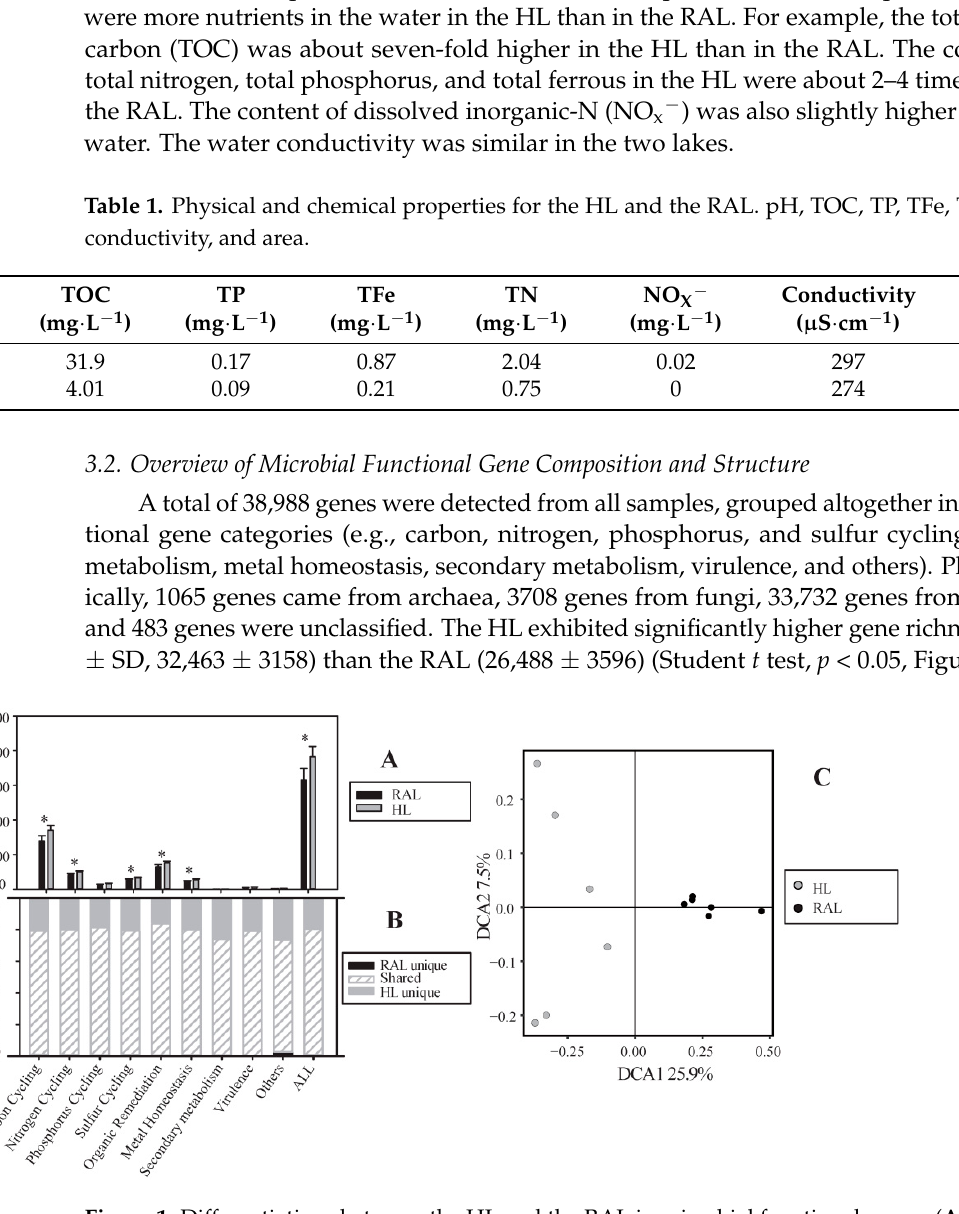
Figure 1. Differentiations between the HL and the RAL in microbial functional genes. ( A ) gene rich- ness, significant differences between the HL and the RAL were signified with the “*” above the middle of bars for different gene categories; ( B ) the distributions (shared or unique) of the detected genes in certain biogeochemical cycling processes; and ( C ) the plot showing detrended correspondence analysis results based on the Bray–Curtis dissimilarity of functional gene